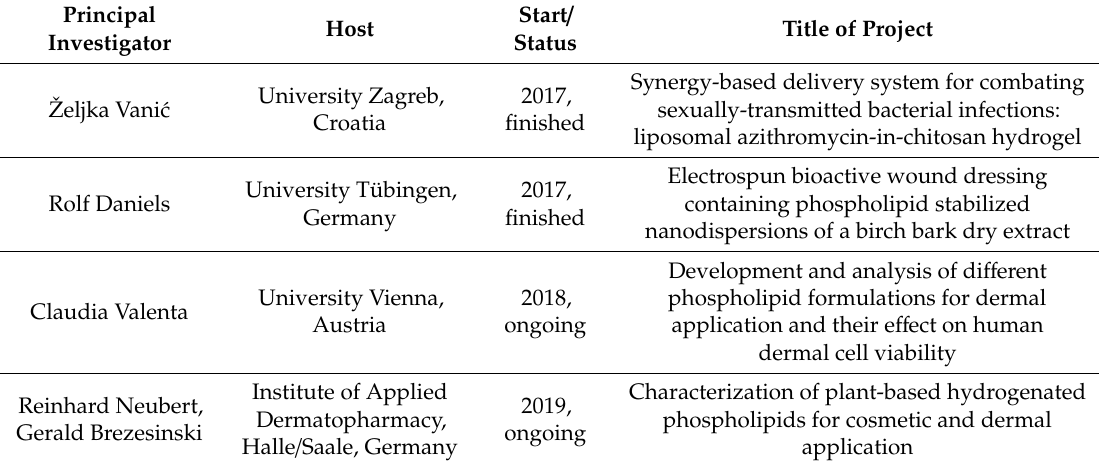
Overview of PRC-funded research projects (2017–now) covering the topical use of lipid-based